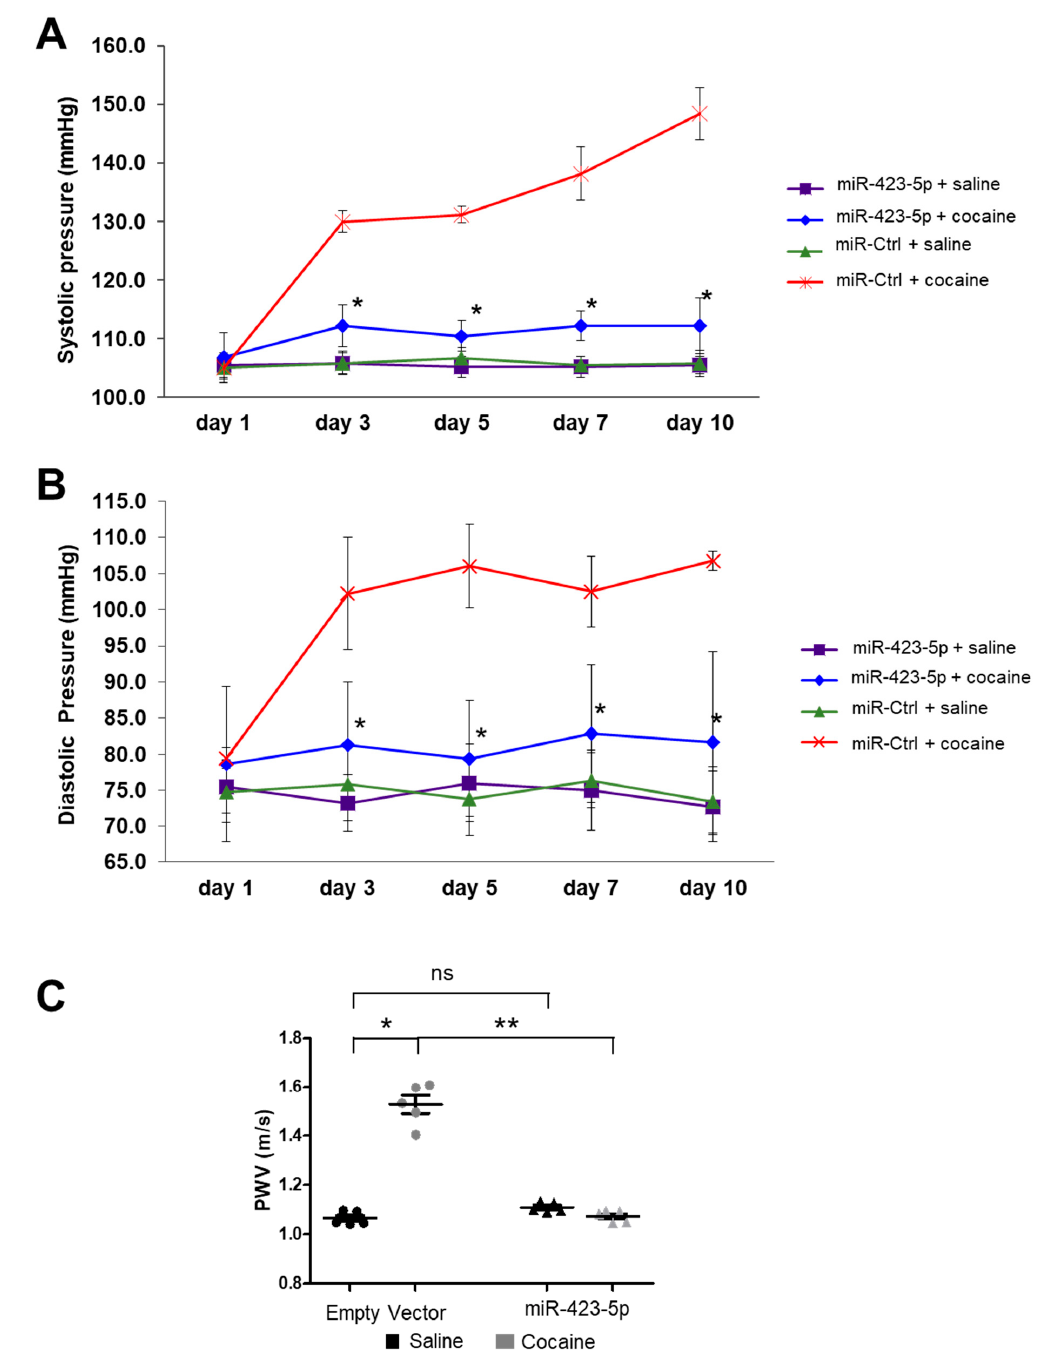
Figure 7. SMC-specific miR-423-5p ameliorated cocaine-induced increase BP and aortic stiffness in mice. Mice were injected with lentivirus encoding miR-423-5p from the smooth muscle-specific promoter (Sm22) or vector control before exposure to cocaine or PBS for 10 consecutive days. Pretreatment with miR-423-5p resulted in a partially reduction in the cocaine-induced ( A ) systolic and ( B ) Diastolic BP elevation. (* p < 0.05 vs. miR-Ctrl + cocaine). ( C ) Aortic stiffness was measured by pulse wave velocity (PWV) two days following the final treatment with cocaine. Pretreatment of the mice with the miR-423-5p expressing vector abrogates cocaine-induced elevation in aortic stiffness. Stu- dent’s two tailed t -test was used for all statistical analysis (ns: not significant; * p < 0.05 vs. miR-Ctrl; ** p < 0.01 vs. miR-Ctrl + cocaine). Black circles = empty vector + saline, gray circles = empty vector + co- caine, black triangle = miR-423-5p + saline, gray triangles = miR-423-5p +